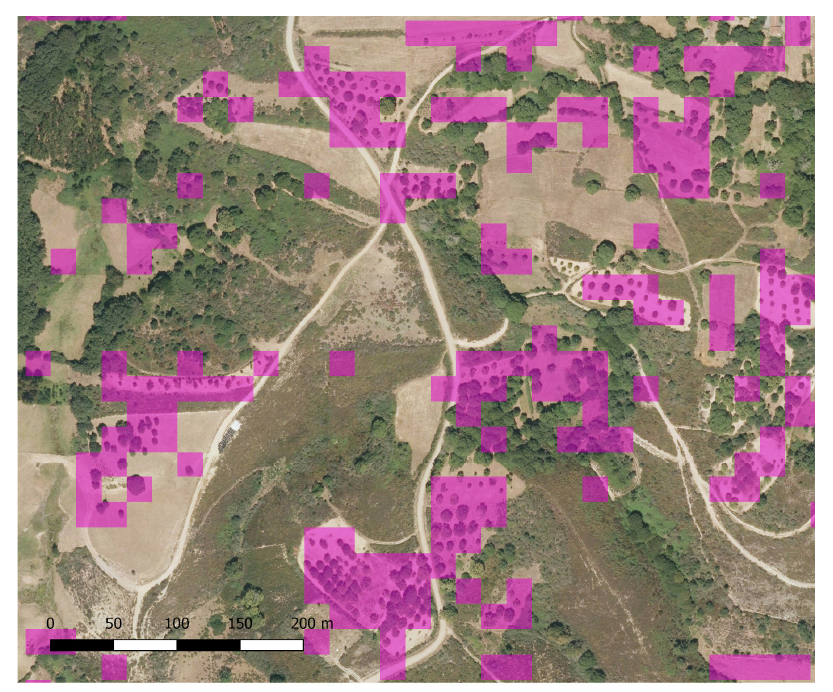
Figure 6. Plot of the Mean Decrease in Gini for each variable in Model 2.